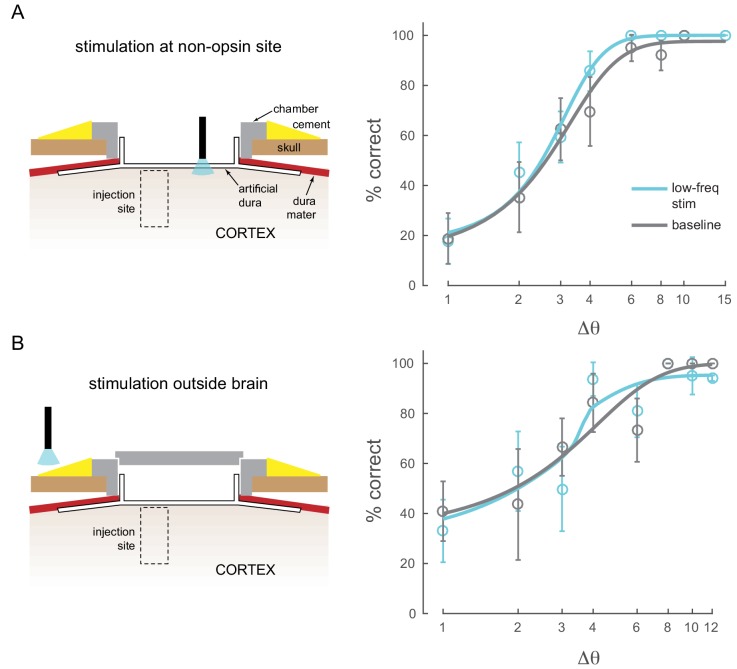
Other control conditions.(A) Stimulation at a non-opsin site does not perturb behavior. (B) Stimulation with optical fiber outside the brain (with the opto-physiology chamber closed) does not perturb behavior.